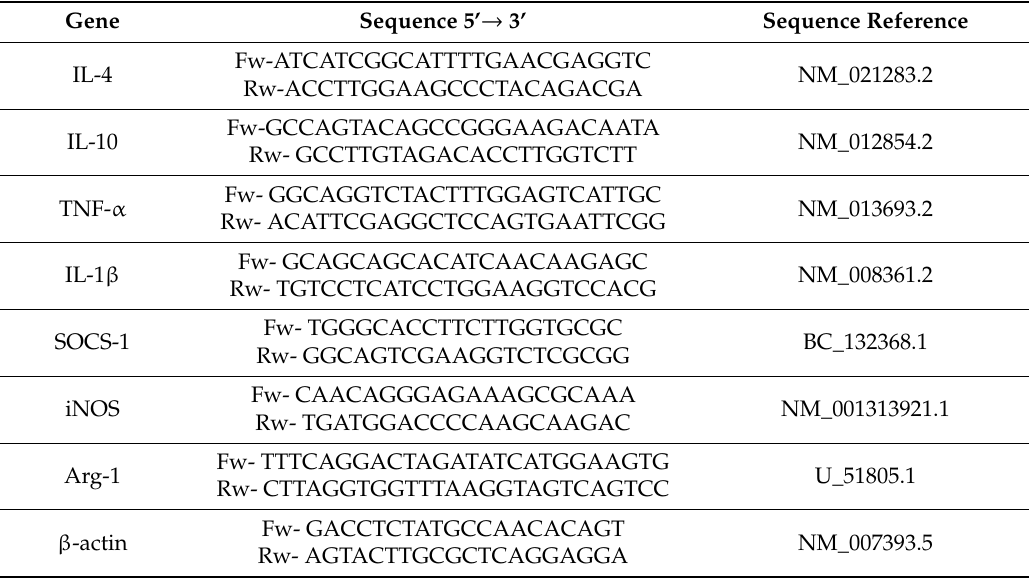
Table 1. DNA sequences of primers used in PCR